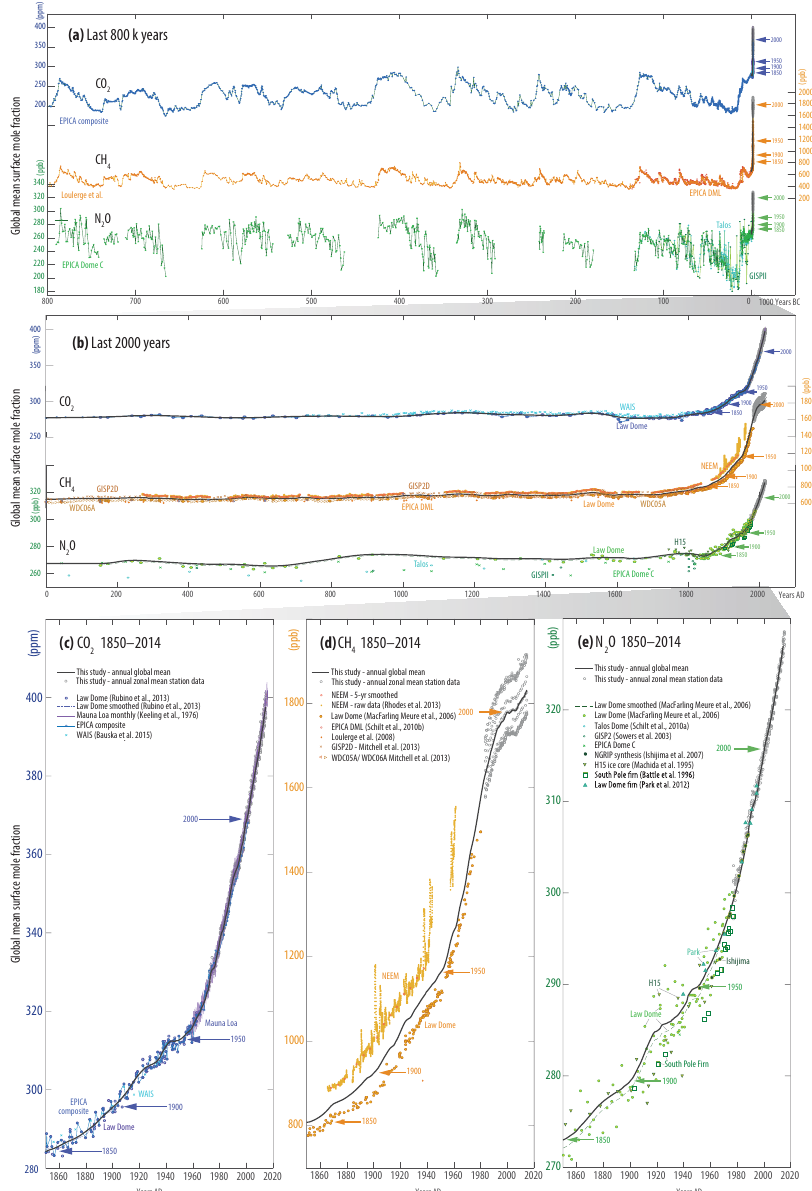
Figure 6. Atmospheric CO 2 , CH 4 and N 2 O concentrations over different timescales, from 800000 years ago until today (a) , over the last 2000 years (panel b) and over 1850–2014 (c, d, e) . The shown data is for CO 2 : Mauna Loa data by Keeling et al. (1976); the Law Dome ice record (Etheridge et al., 1998; MacFarling Meure et al., 2006; Rubino et al., 2013), updated for minor dating changes and placed on current NOAA scales; NOAA ESRL station data (NOAA, 2013; NOAA ESRL GMD, 2014a, b, c); the EPICA composite data (Ahn and Brook, 2014; Bereiter et al., 2015; Bereiter et al., 2012; Lüthi et al., 2008; MacFarling Meure et al., 2006; Marcott et al., 2014; Monnin et al., 2004; Petit et al., 1999; Rubino et al., 2013; Schneider et al., 2013; Siegenthaler et al., 2005); and the WAIS data (Bauska et al., 2015). For CH 4 , the shown data is the Law Dome data (Etheridge et al., 1998; MacFarling Meure et al., 2006), the instrumental data from the NOAA and AGAGE networks (see Table 3), NEEM ice core measurements (Rhodes et al., 2013), the EPICA Dronning Maud Land ice core record (Barbante et al., 2006; Capron et al., 2010; Schilt et al., 2010b), and the long record by Loulergue et al. (2008) as well as the GISP2D, WDC05A and WDC06A records by Mitchell et al. (2013). In case of N 2 O, the shown data is the Law Dome record (MacFarling Meure et al., 2006), the Talos Dome record (Schilt et al., 2010b), the GISPII record (Sowers et al., 2003) and the EPICA Dome C record (Fluckiger et al., 2002; Schilt et al., 2010a; Spahni et al., 2005; Stauffer et al., 2002) in addition to the H15 ice core record from Antarctica (Machida et al., 1995), the South Pole firn record (Battle et al., 1996), the Law Dome firn record “Park” (Park et al., 2012) and a modelling synthesis by Ishijima (2007). For data sources behind “this study’s” composite product, see Tables 2, 3 and